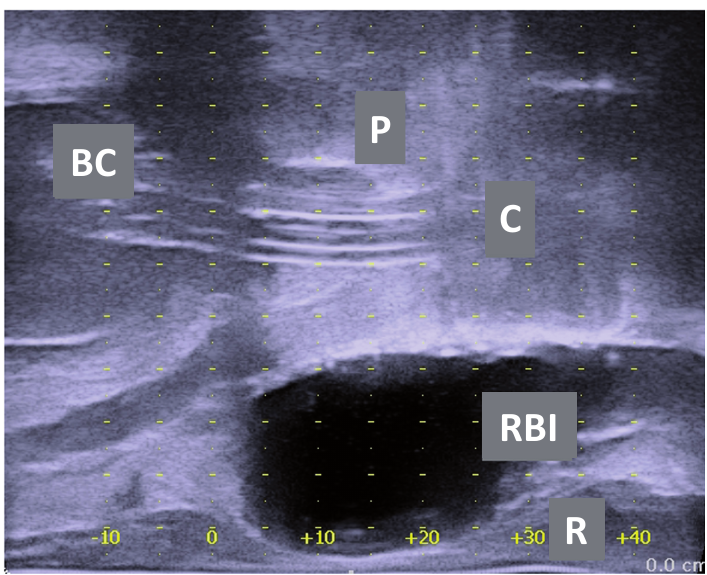
figure 8 - sagittal ultrasound image of patient with a rectum balloon implant (RBI) in situ between the prostate (p) and the rectum (R). The view is in the central plane with the urinary catheter (c) and the foley balloon catheter (Bc) visible in the